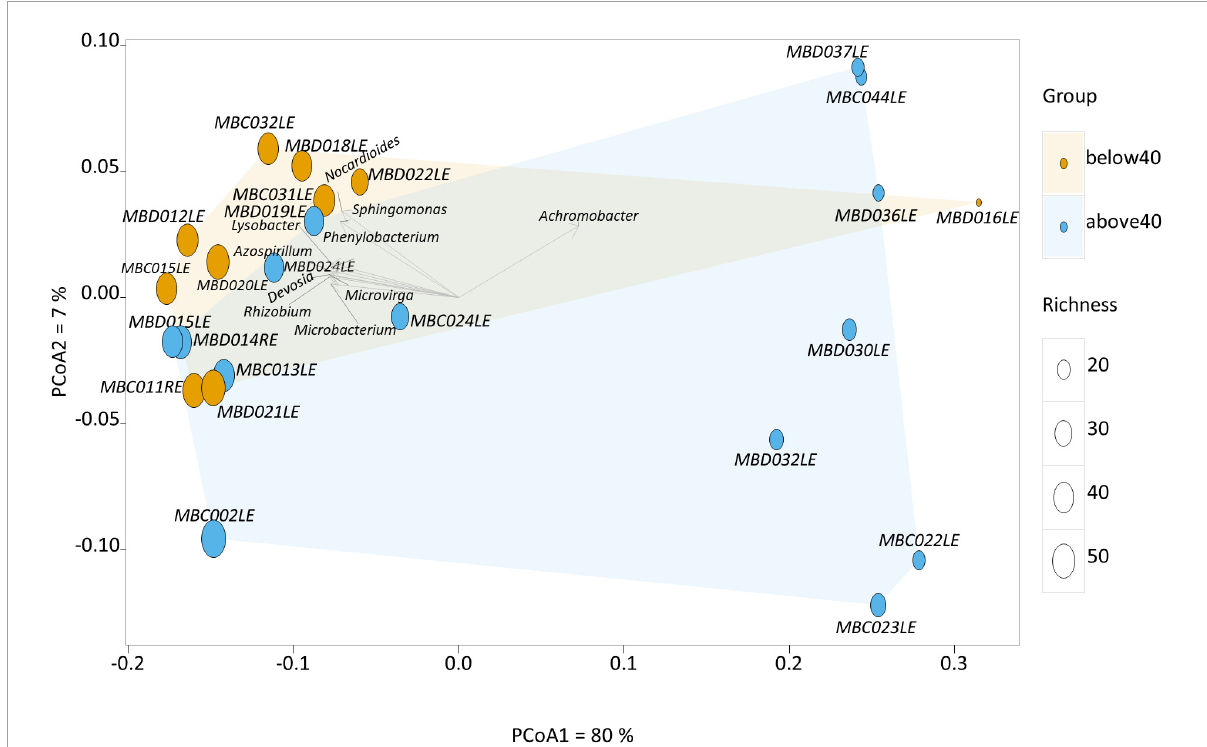
FIGURE1 Principal component analysis of the human conjunctival microbiome composition. This scatter diagram shows each participant (symbol) along the first two principal components of the microbial gene analysis at the genus level. The age of the participant is displayed as either orange (younger) or blue (older), and richness is displayed as differing sizes of the symbols. Certain bacterial genera contribute significantly to loading scores in the first principal component (horizontal axis) illustrated in the scatter